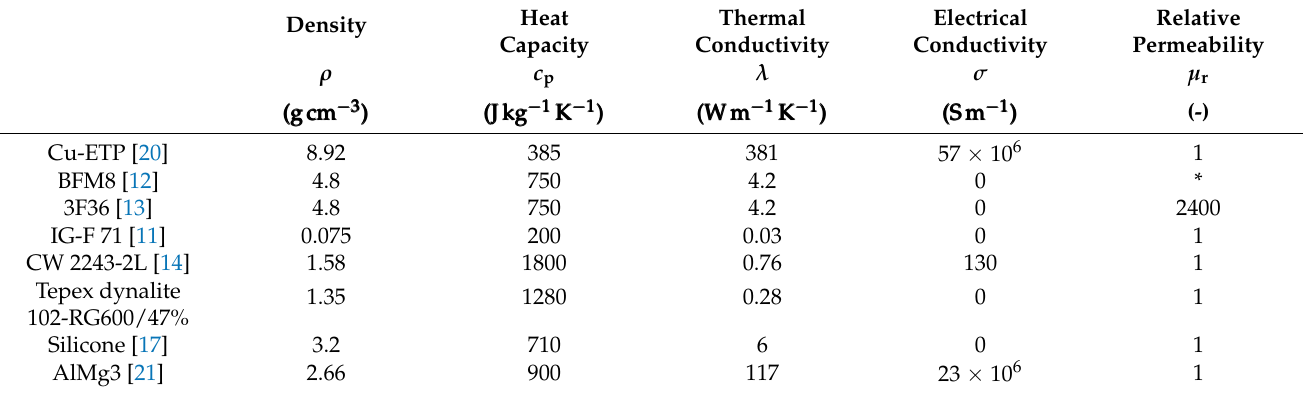
Table 2. Material properties of the used CPM